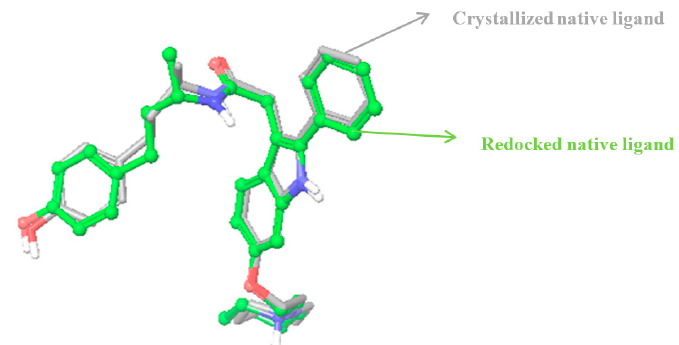
Figure 2. Docking control. Top ranked ligand pose for the native ligand, compound 11F 3-(4-hydroxyphenyl)-1-methylpropyl]-2-[2-phenyl-6-(2-piperidin-1-ylethoxy)-1h-indol-3-yl]acetamide- LBD hER α superimposed with co-crystallized native ligand.